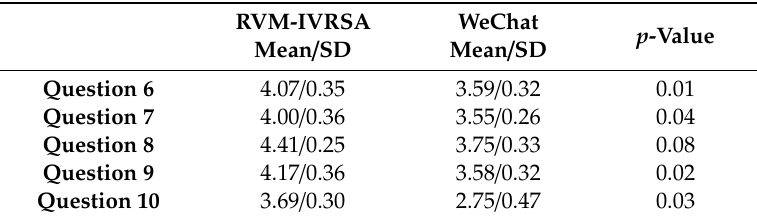
Table 2. Online social experience score.